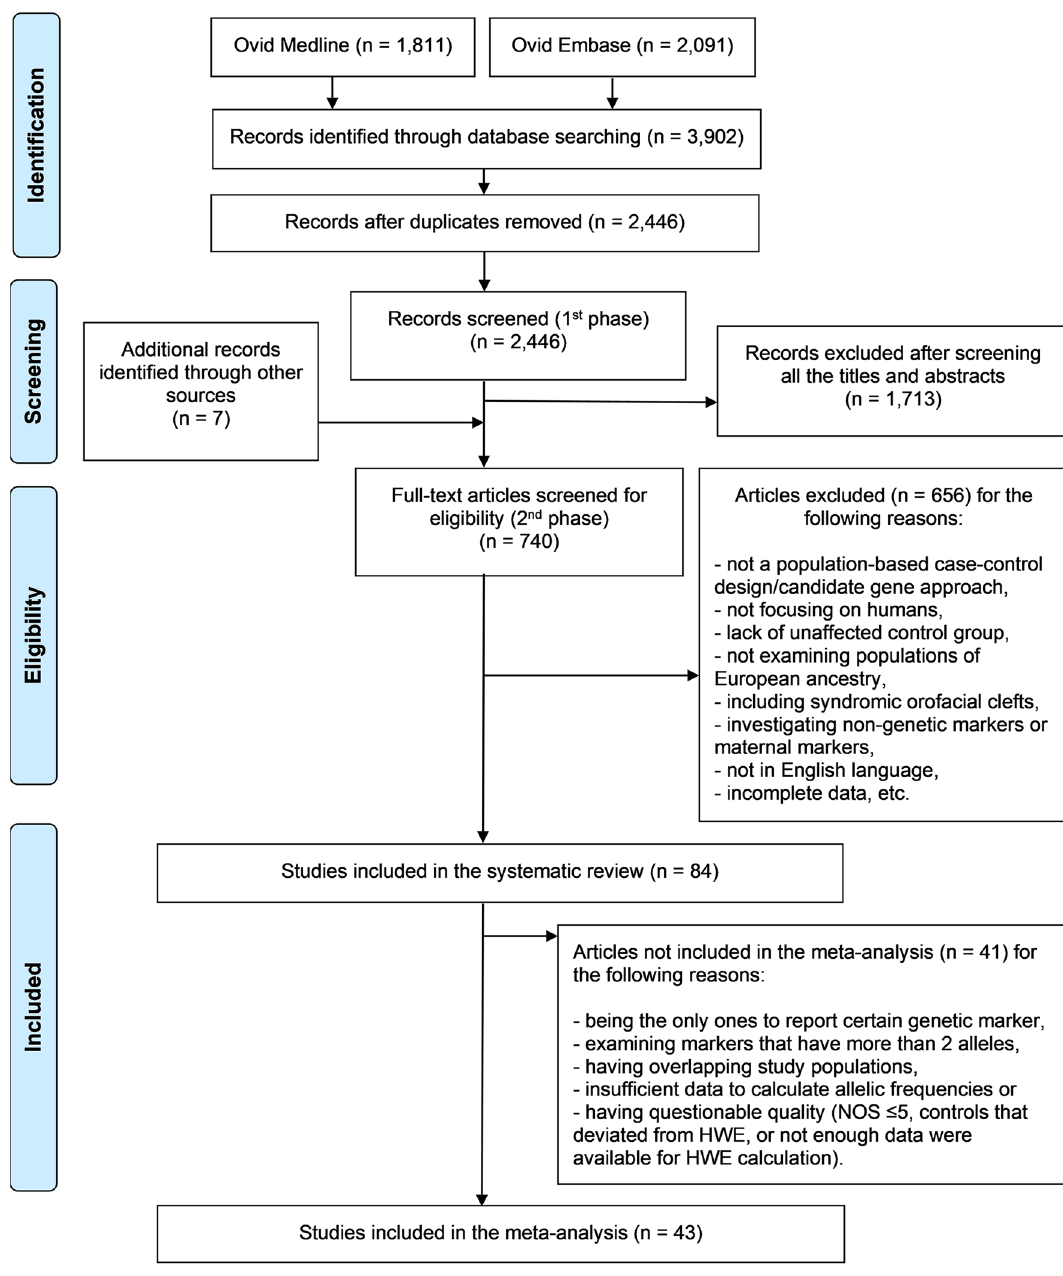
Figure 1. Flowchart of study identification and